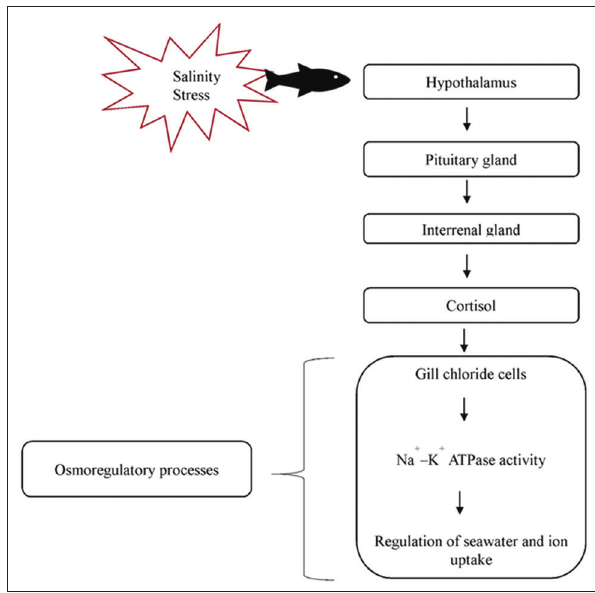
Figure-3: The experimental design for measurement of serum cortisol level in Epinephelus fuscoguttatus exposed to different salinities. 200 fingerlings were acclimatized in a 500 L tank with 31 ppt salinity for 2 weeks. After acclimatization, 10 fish were introduced into each tank containing 22 L seawater adjusted at different salinities of 31 ppt, 25 ppt, 20 ppt, 15 ppt, 10 ppt, and 5 ppt with triplicates. Blood sampling was done after 5, 30, 60, and 120 min followed by observation for survival percentage for 2 weeks.